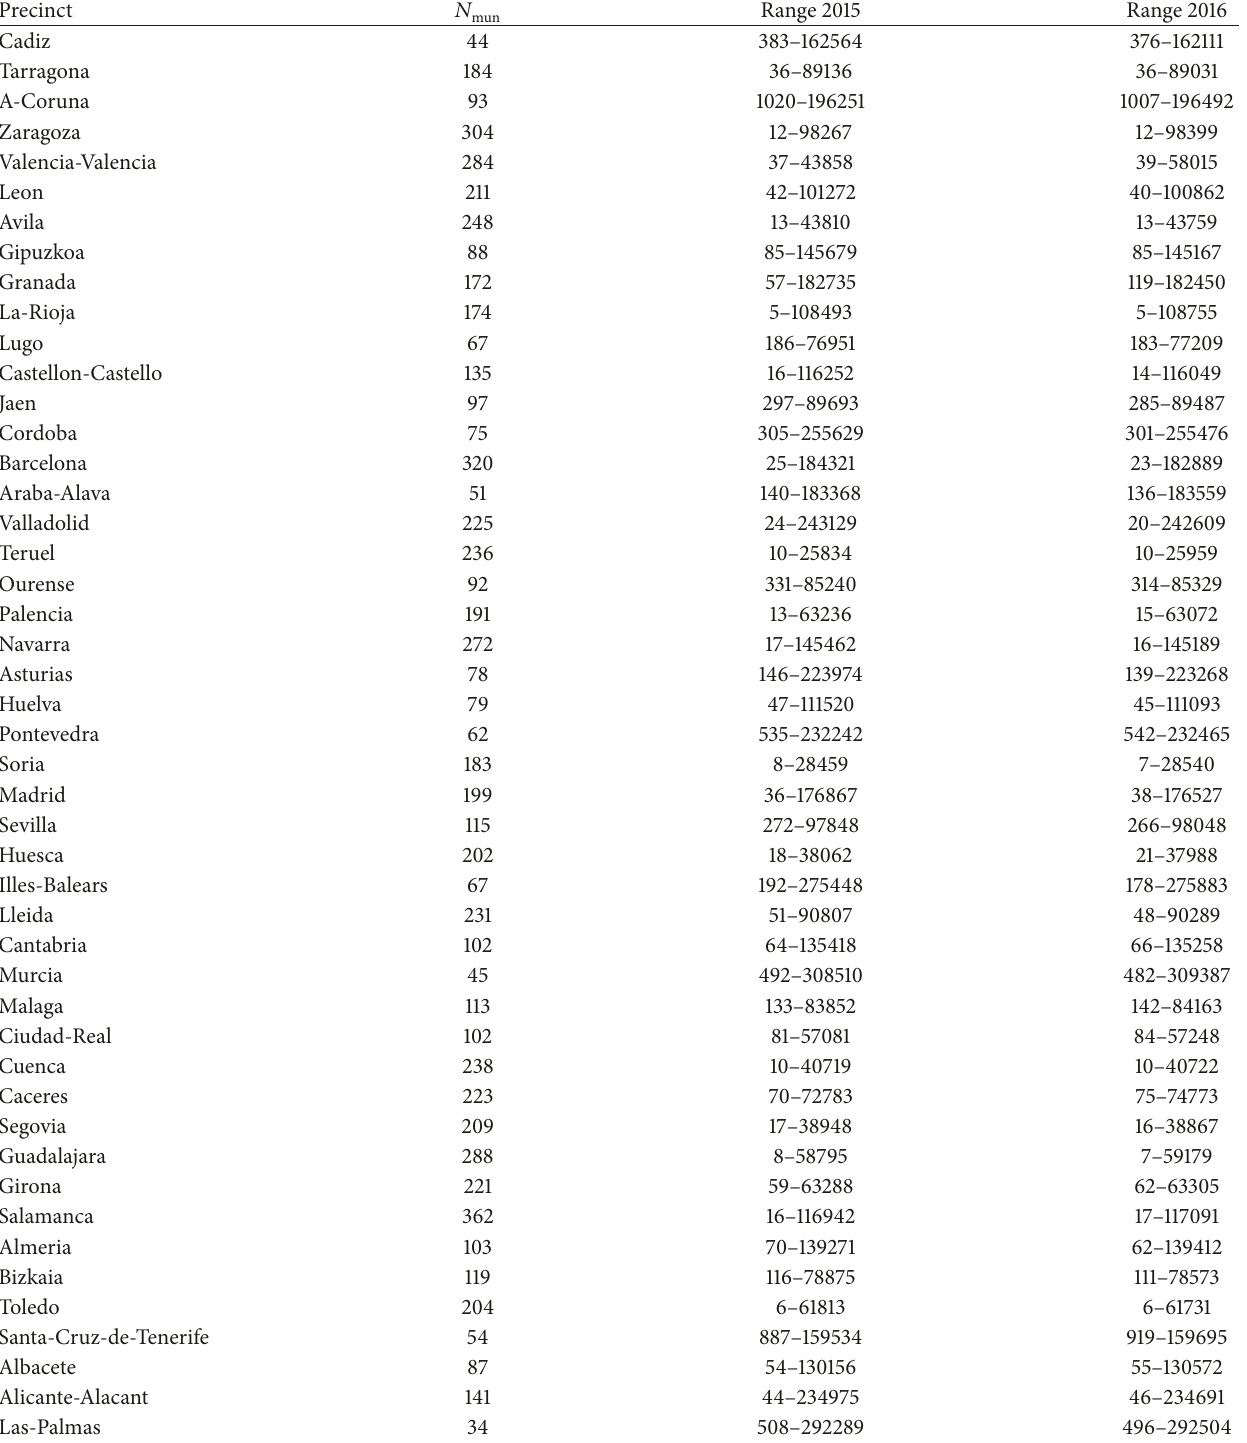
Table 2: List of precincts with their number of different municipalities and the voting population ranges (by voting population we mean the number of possible voters). The largest cities, such as Madrid, Barcelona, Bilbao, Sevilla, Valencia, Zaragoza and Malaga, have been subsequently divided into electoral districts and we have treated these latter districts as